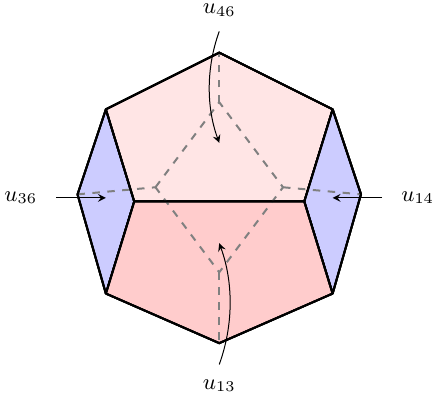
Figure 6. The A 3 polytope with four faces labelled by their dihedral coordinates. The double scaling limits u 46 ! 0 and its parity conjugate version u 13 ! 0 are are the highlighted red pentagons. The soft limits u 36 ! 0 and u 14 ! 0 are the blue squares. The line joining the two squares corresponds to the collinear limit u 13 = u 46 =